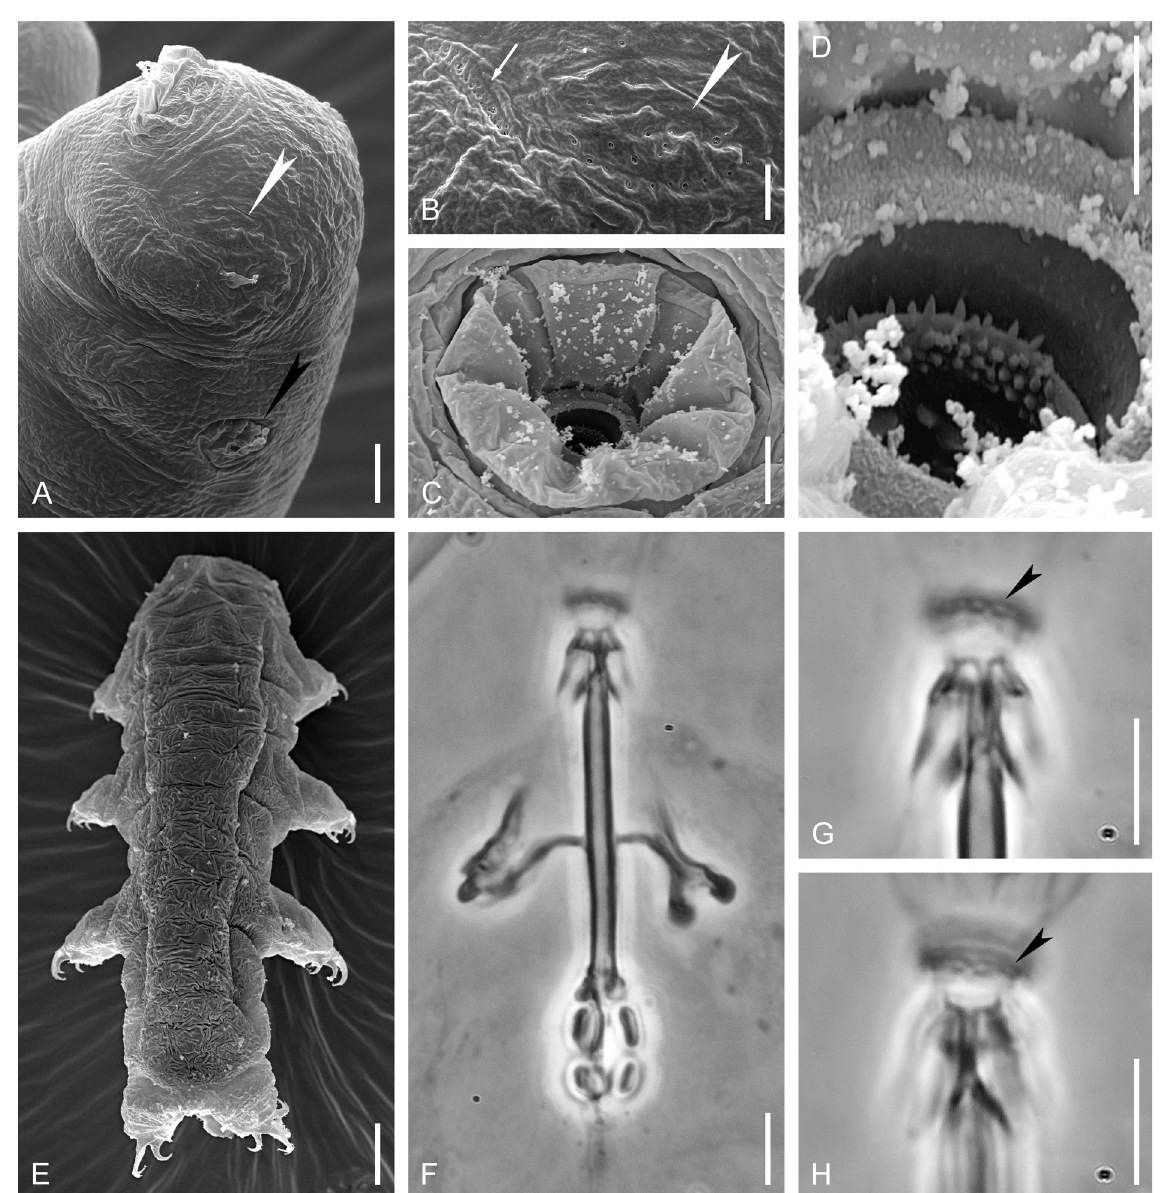
Fig. 4. Hypsibius pallidoides Pilato, Kiosya, Lisi, Inshina & Biserov, 2011. A . Lateral view of the head region, white arrowhead indicates the anterior porous area, black arrowhead indicates the elliptical sensory organ, SEm. B . Enlarged view of the lateral surface of the head, white arrowhead indicates the anterior porous area, white arrow indicates the muscle attachment zone, SEm. C . mouth opening with peribuccal lobes, SEm. D . mouth opening with anterior ring of teeth, SEm. E . Dorsal sculpture of the juvenile, SEm. F . Bucco-pharyngeal apparatus (SPbu 251(82)), PhC. G . Dorsal view of the buccal cavity, black arrowhead indicates the circumoral elliptical structures (SPbu 251(82)), PhC. H . Ventral view of the buccal cavity, black arrowhead indicates the circumoral elliptical structures (SPbu 251(82)), PhC. Scale bars: A, F–H = 5 µm; B–C = 2 µm; D = 1 µm; E = 10